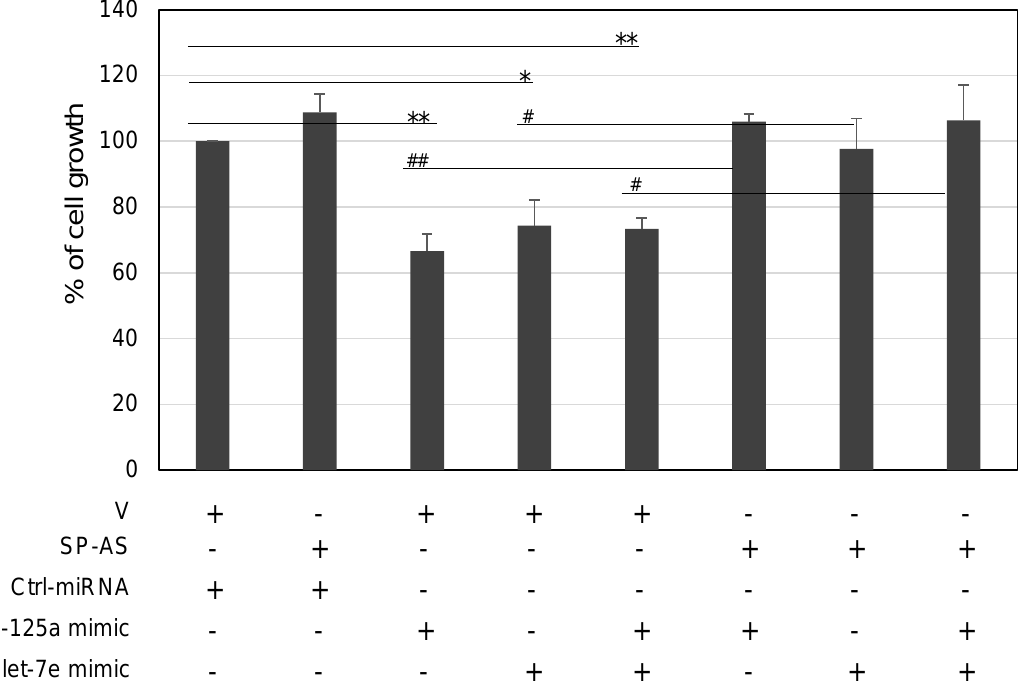
Figure 5. E ff ect of SP-AS overexpression on the antiproliferative activity of miR-125a and let-7e. HuH-7 cells were transfected with miRNA mimics and their antiproliferative activity was evaluated with or without ectopic expression of SP-AS by MTT assays. Cell growth of cells transfected with control molecules (parental vector, V and unrelated miRNA mimic, Ctrl-miRNA) was set to 100; data are reported as mean ± s.d. of replicate analyses. p values at Student’s t -test between the indicated experimental groups were * or # p < 0.05; ** or ## p <